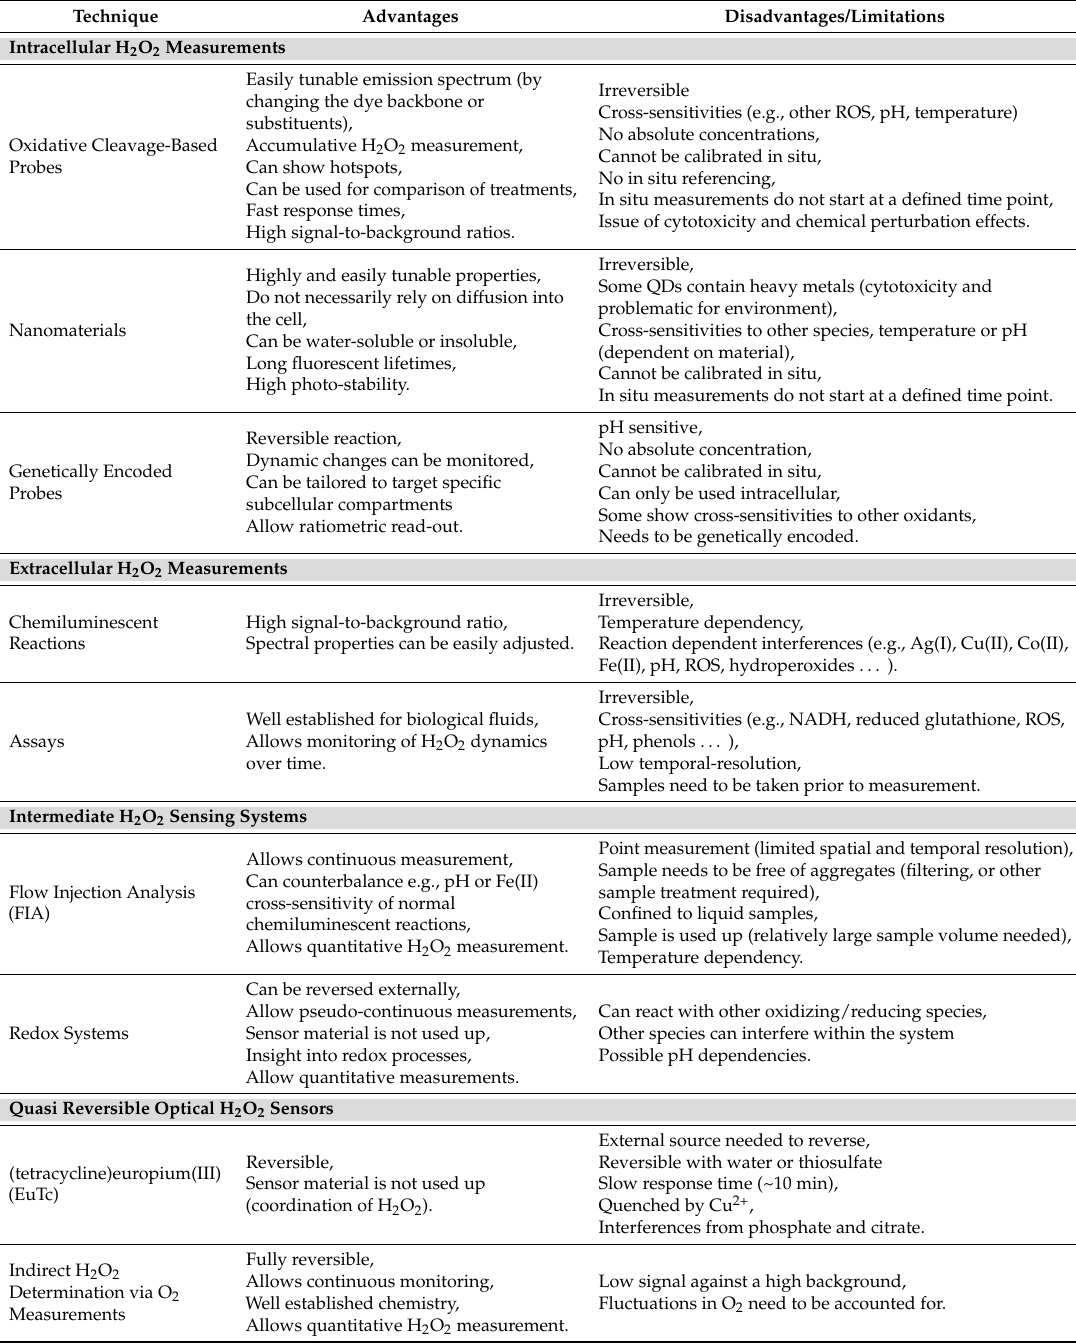
Table 1. Advantages, disadvantages and limitations of optical, chemical H 2 O 2 detection schemes.